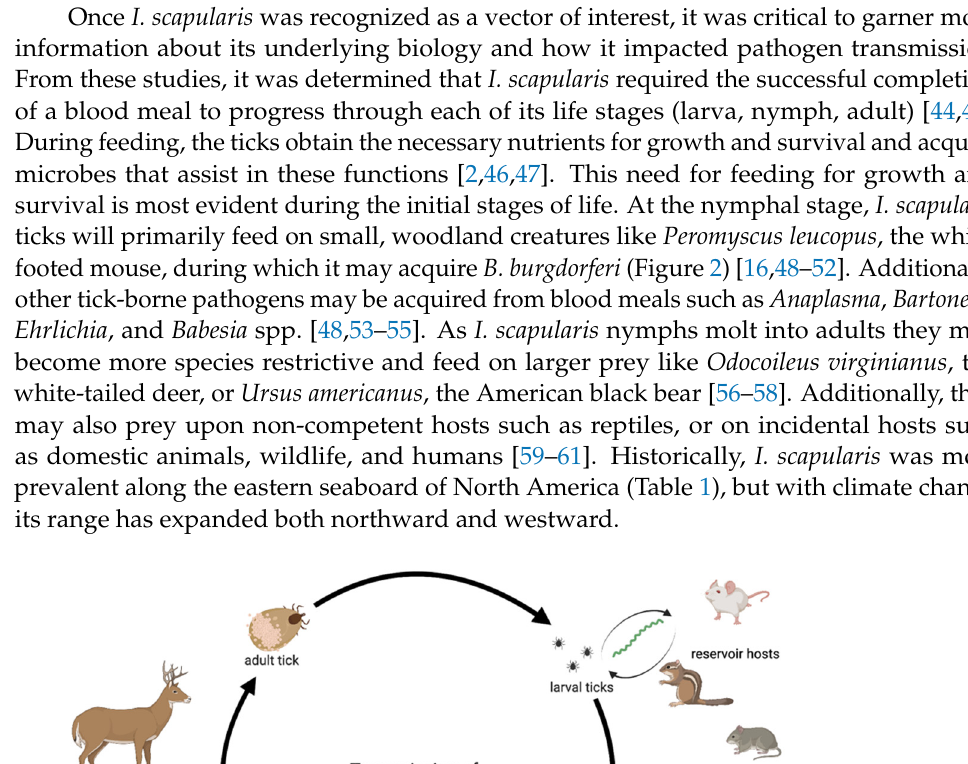
Table 2. Leading tick-borne pathogens within the United States and their vectors.